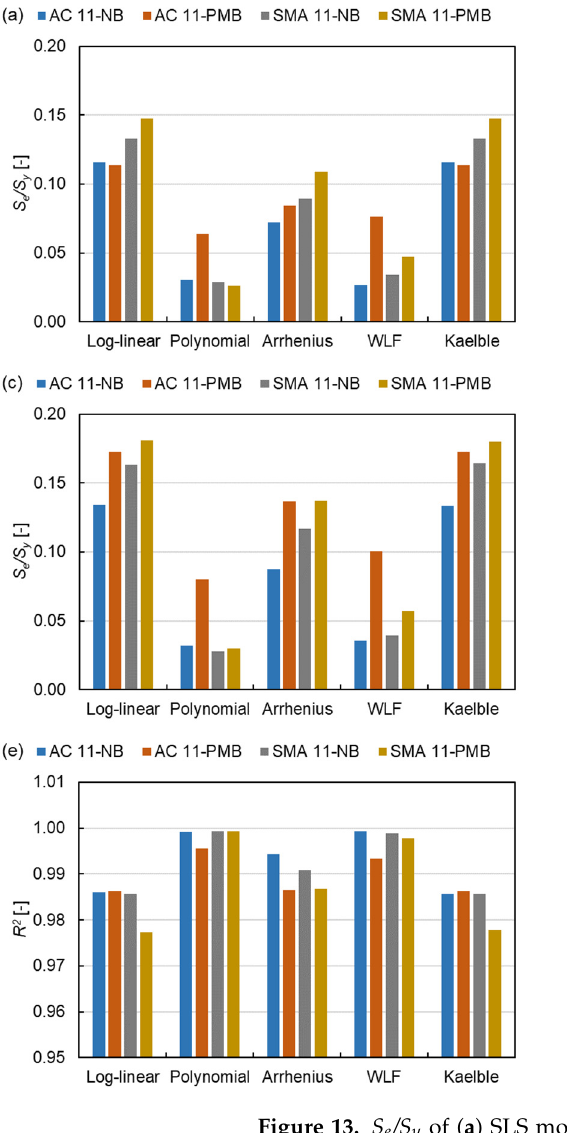
Figure 13. S e /S y of ( a ) SLS model, ( b ) GLS model and ( c ) CAM model and R 2 of ( d ) SLS model, ( e ) GLS model and ( f ) CAM model.